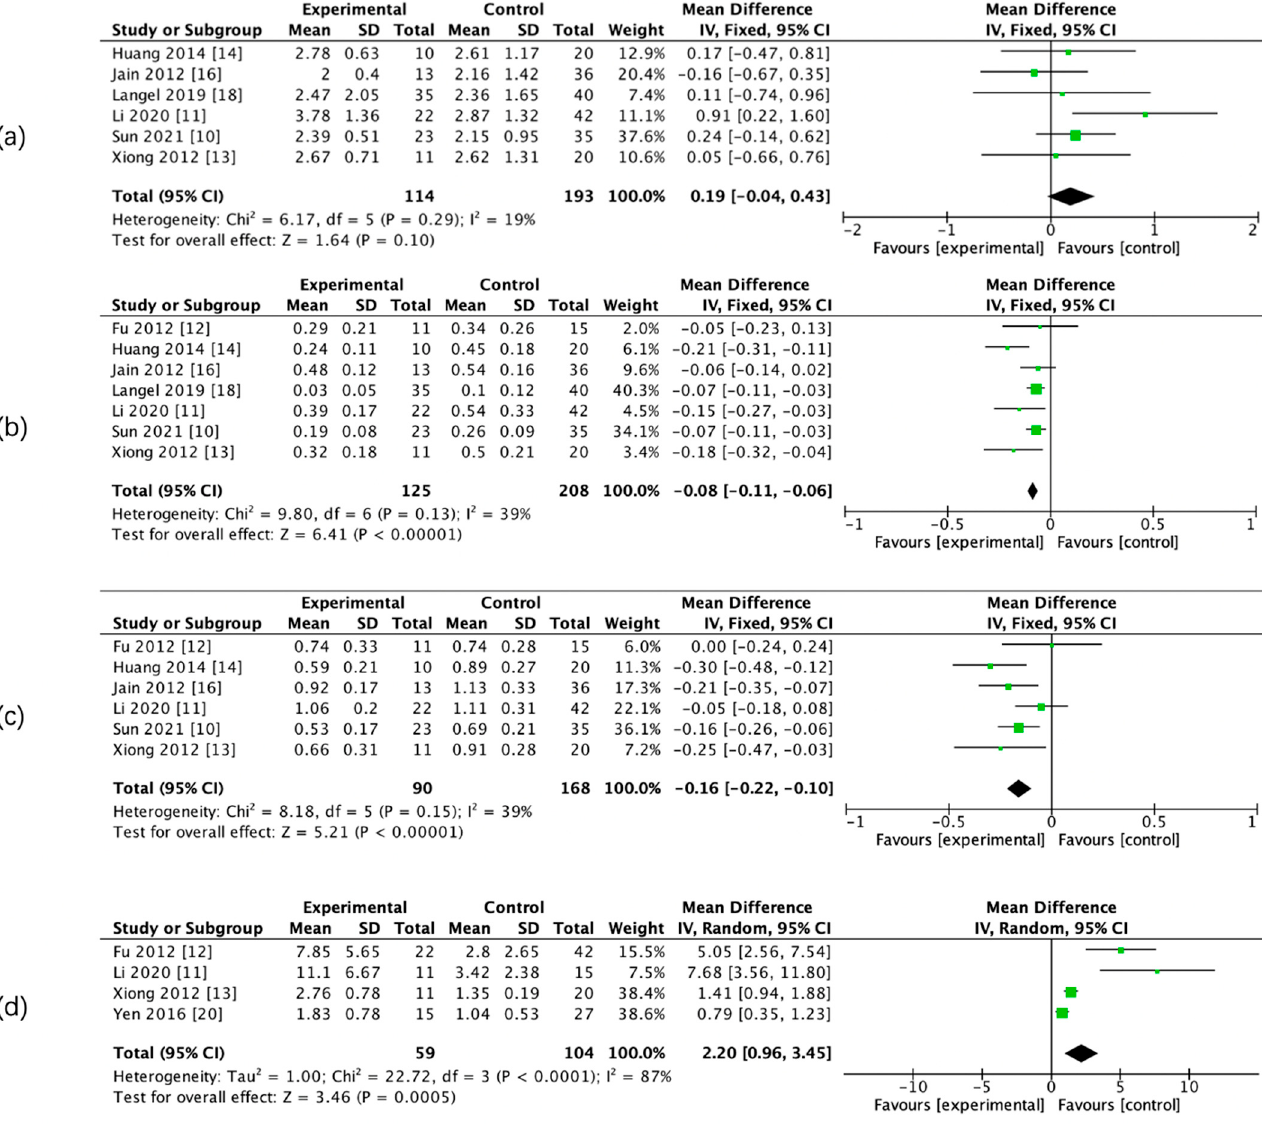
Figure 4. Forest maps of relative CTP parameters for HT and non ‐ HT groups. Relative mean transit